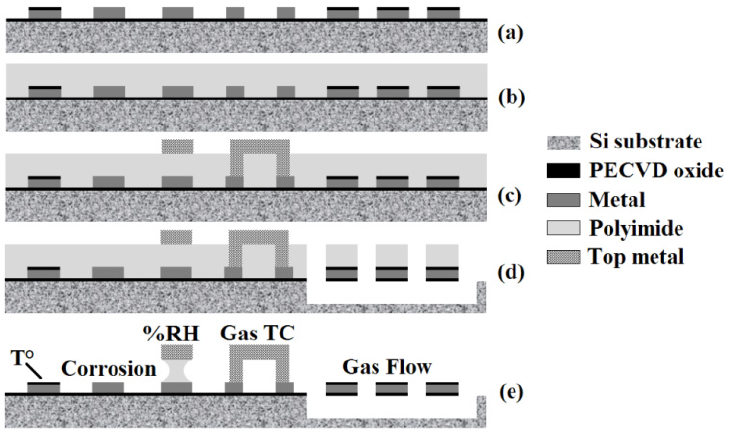
Figure 2. Schematic of the Microelectromechanical Systems (MEMS)-based multisensor fabrication